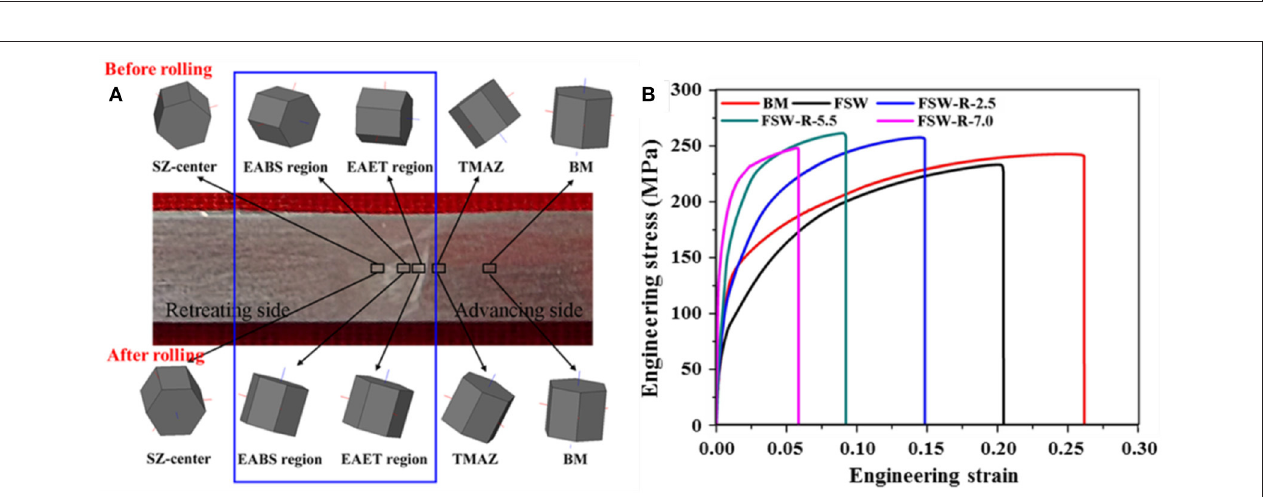
FIGURE 11 | (A) Schematic illustration of the changes of crystallographic orientation after subsequent rolling process for FSW AZ31Mg alloy; (B) stress-strain curves of the transverse tensile tests (Xin et al., 2013b) (Copyright © 2013, ELSEVIER S.A.).